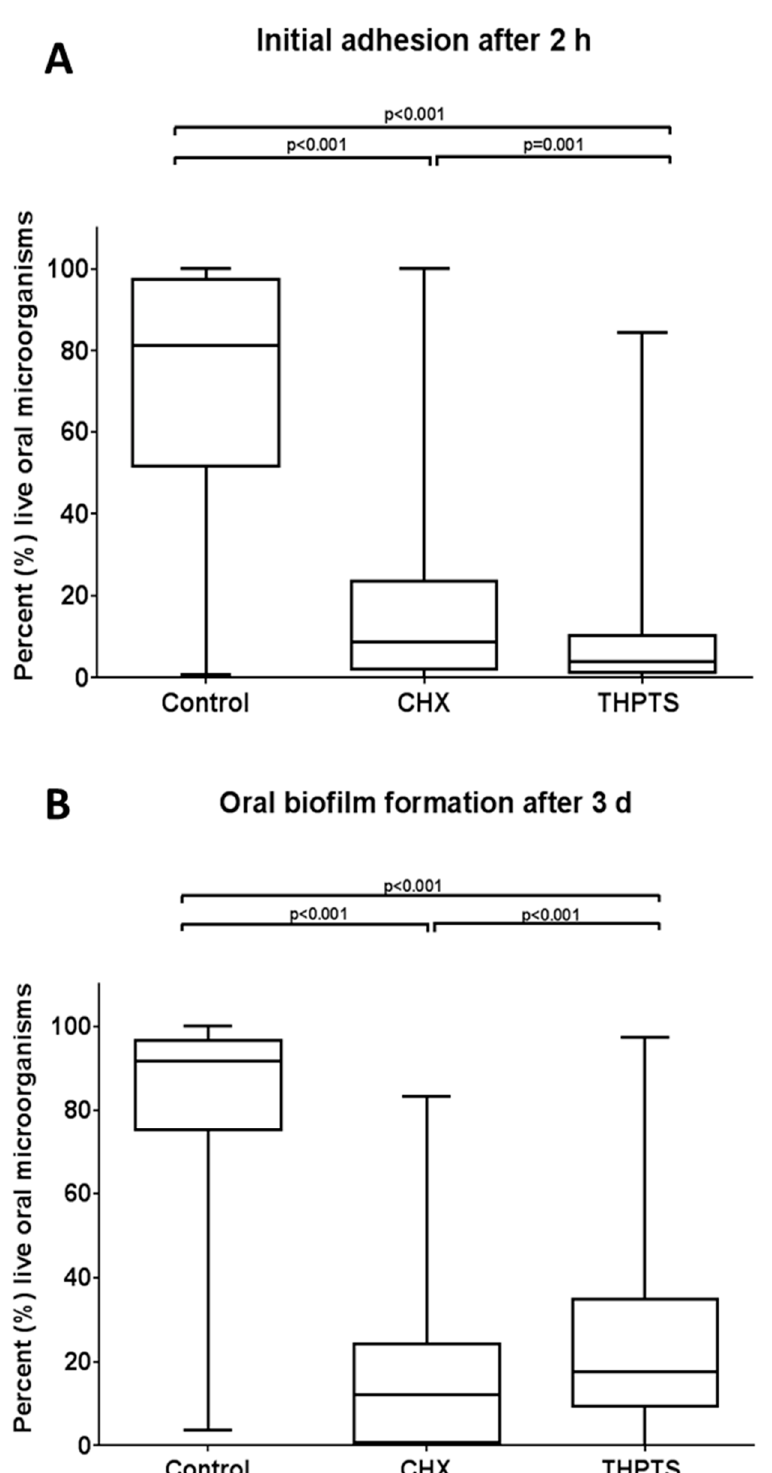
Figure 4. Boxplots demonstrating vitality percentages of oral bacteria during initial adhesion ( A ) and biofilm formation ( B ), respectively, as revealed by live-dead staining after the antimicrobial photodynamic therapy (aPDT). Tetrahydroporphyrin-tetratosylate (THPTS) served as a photosen- sitizer. Untreated and 0.2% chlorhexidine-treated (CHX) samples were also tested as negative and positive controls, respectively. The central line shows the median; whiskers indicate the minimum and maximum. The data’s significant p -values (ANOVA, Scheffé adjustment) are noted on the graphs.